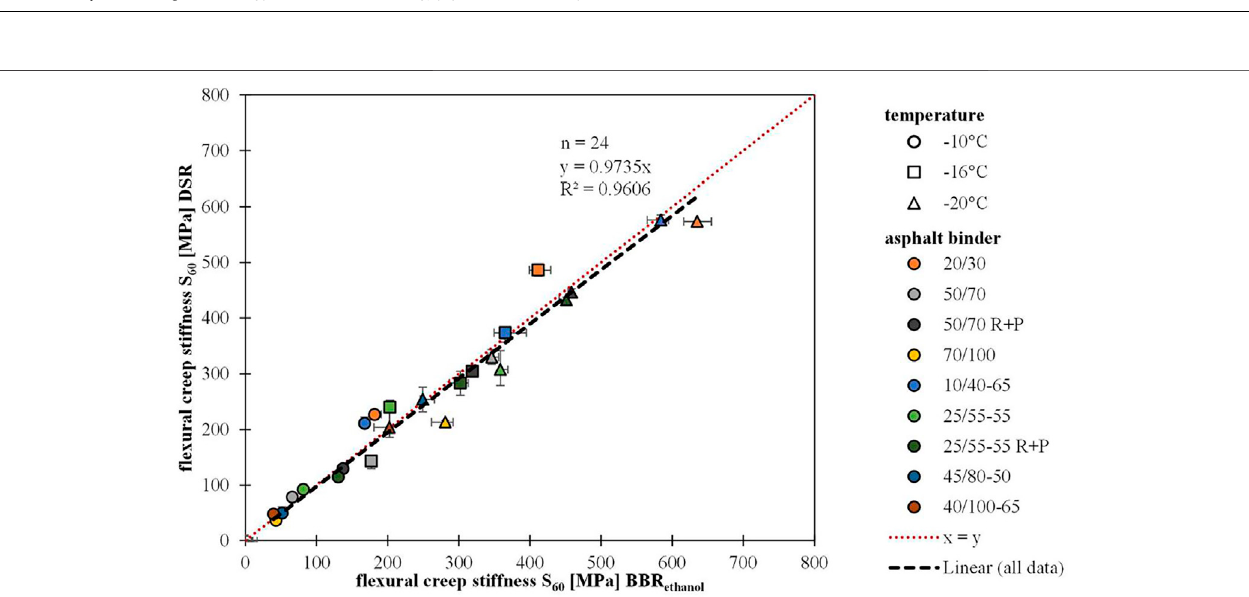
Frontiers in Materials |